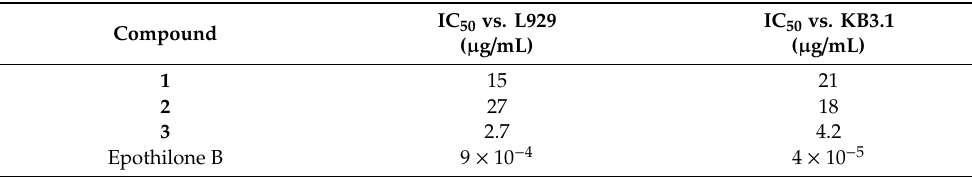
Table 4. Cytotoxicity of compounds 1 – 3